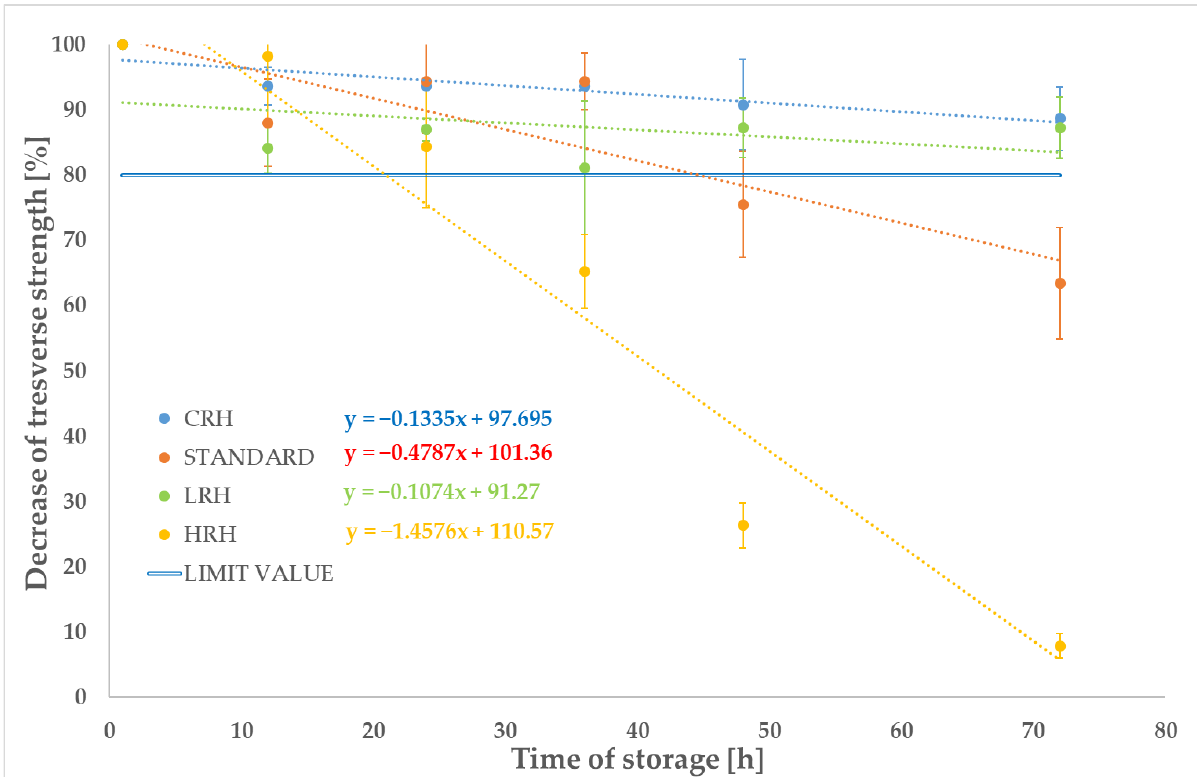
Figure 3. Decrease of transverse strength in % depending on the time of storage under different storage conditions, average values calculated from three measurements are captured, error bars represent the standard deviation: CRH—Constant relative humidity, low temperature—RH = 60% ± 5%, t = 10 ◦ C; STANDARD—Laboratory ambient conditions—RH = 60% ± 5%, t = 25 ◦ C; LRH—Low relative humidity, constant temperature—RH = 10% ± 5%, t = 25 ◦ C; HRH—High relative humidity, constant temperature—RH = 90% ± 5%, t = 25 ◦ C.